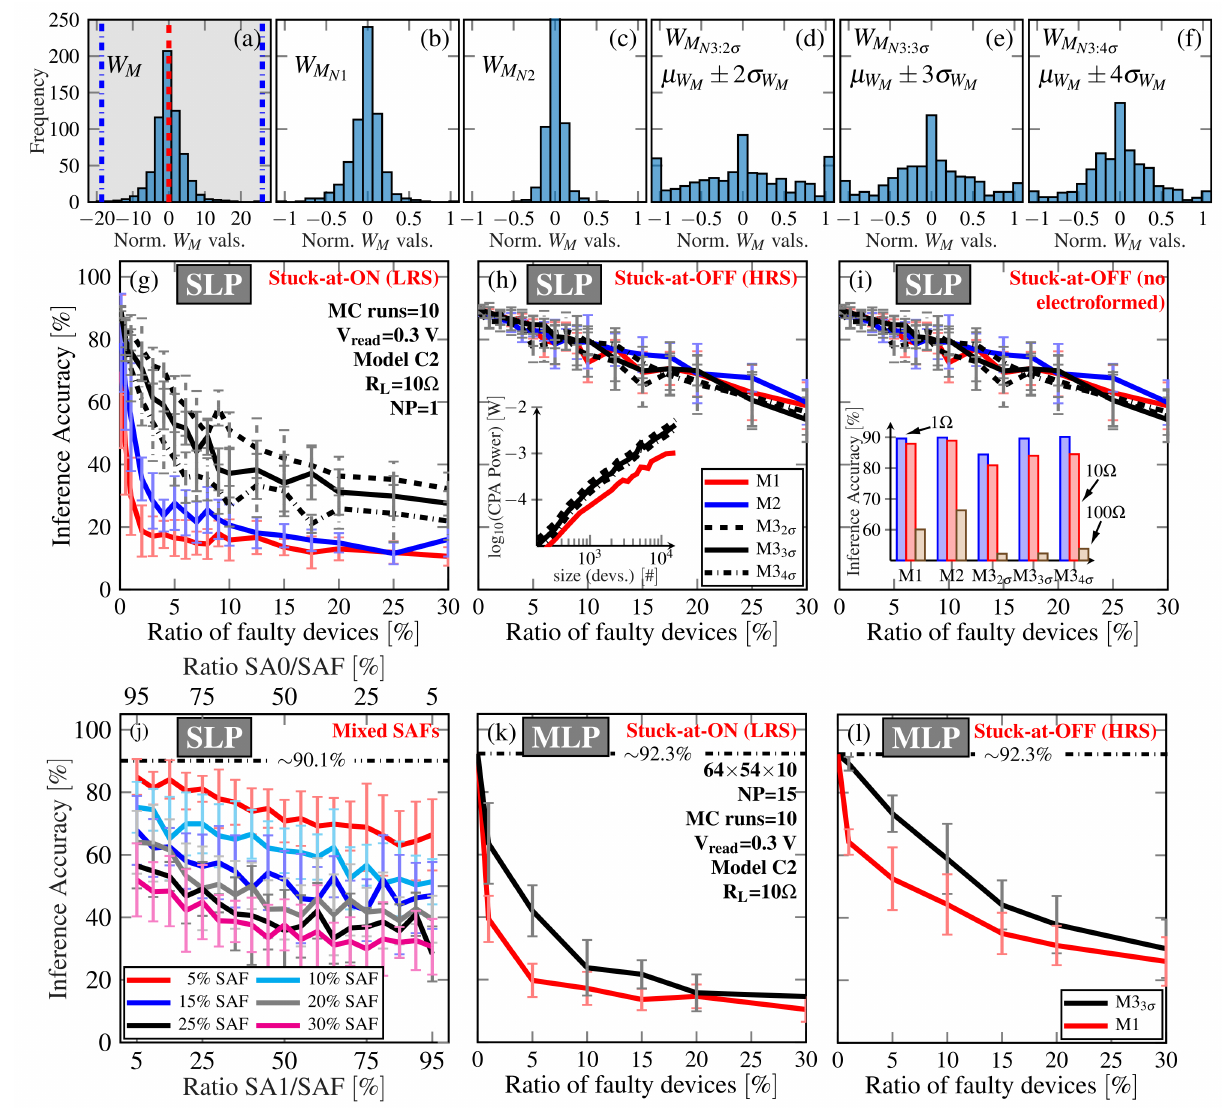
Figure 3. The change in the distribution of the elements of W M ( a ) under different normalisation techniques is shown in ( b – f ). Inference accuracy as function of the FD ratio, considering different W M normalisation approaches, is presented for ( g ) SA1, ( h ) SA0, and ( i ) SA0_nE faults. The SLP power consumption during the inference phase is indicated in the inset of ( h ) as a function of the SLP size. Similarly, the inference accuracy of the fault-free SLP under different normalisation methods is presented in ( i ). ( j ) Inference accuracy assuming different combinations of SA1 and SA0 faults. Note that the ratio of SAFs (containing both SA1 and SA0) is swept parametrically from 5% to 30%. ( k ) and ( l ) show the inference accuracy of an MLP ANN as a function of the ratio of SAFs, assuming SA1 and SA0,